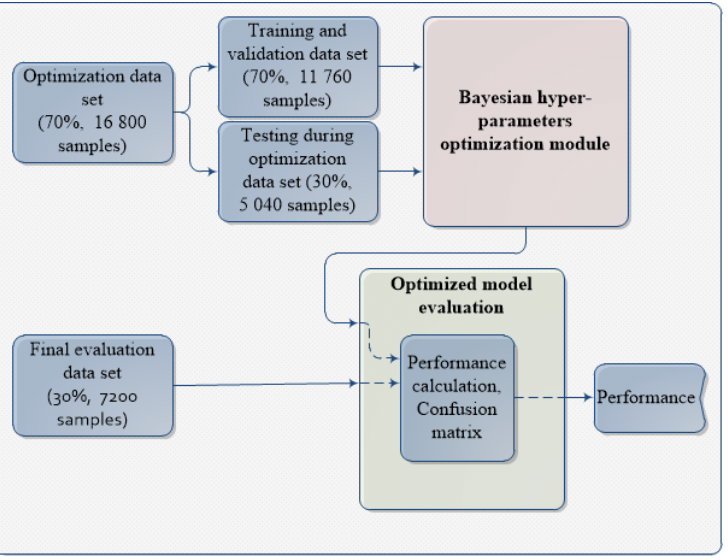
Figure 3. Optimization and evaluation process